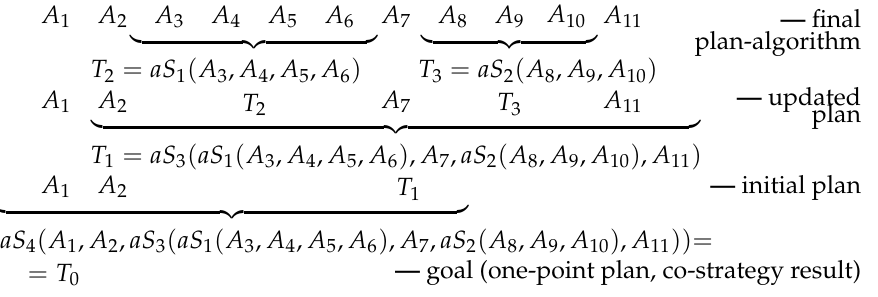
Figure 8. Representation of the implementation of strategies using a functional-theoretic model for the introduction of a